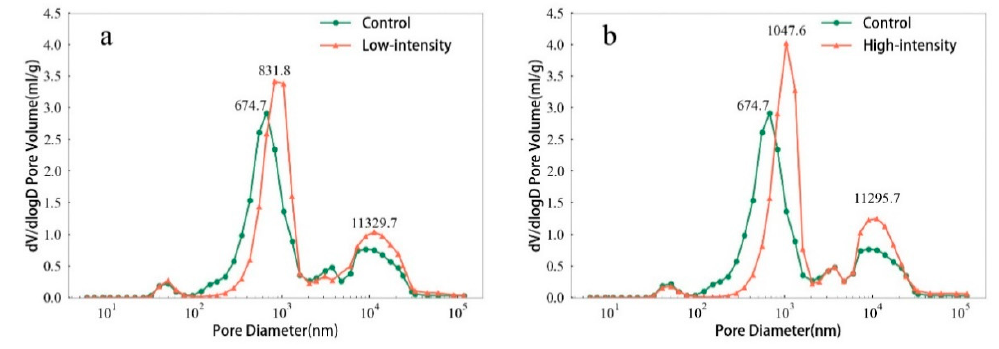
Figure 7. Log di ff erential intrusion versus pore diameter of samples under di ff erent intensities: Figure 7. Log differential intrusion versus pore diameter of samples under different intensities: ( a ) ( a ) Low-intensity, ( b ) Low ‐ intensity, ( b ) high ‐ intensity.